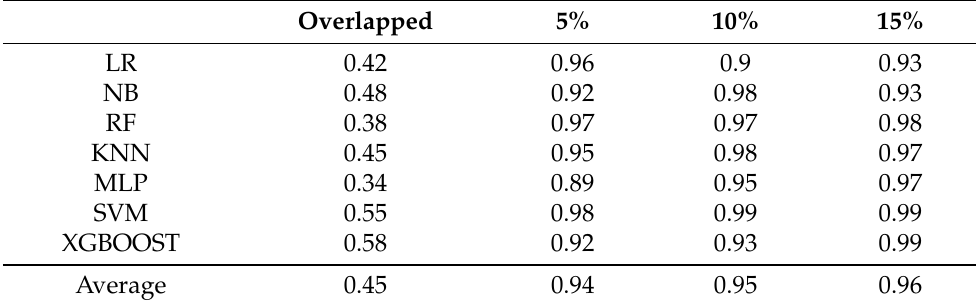
Table 3. Performance comparison of classifiers in terms of